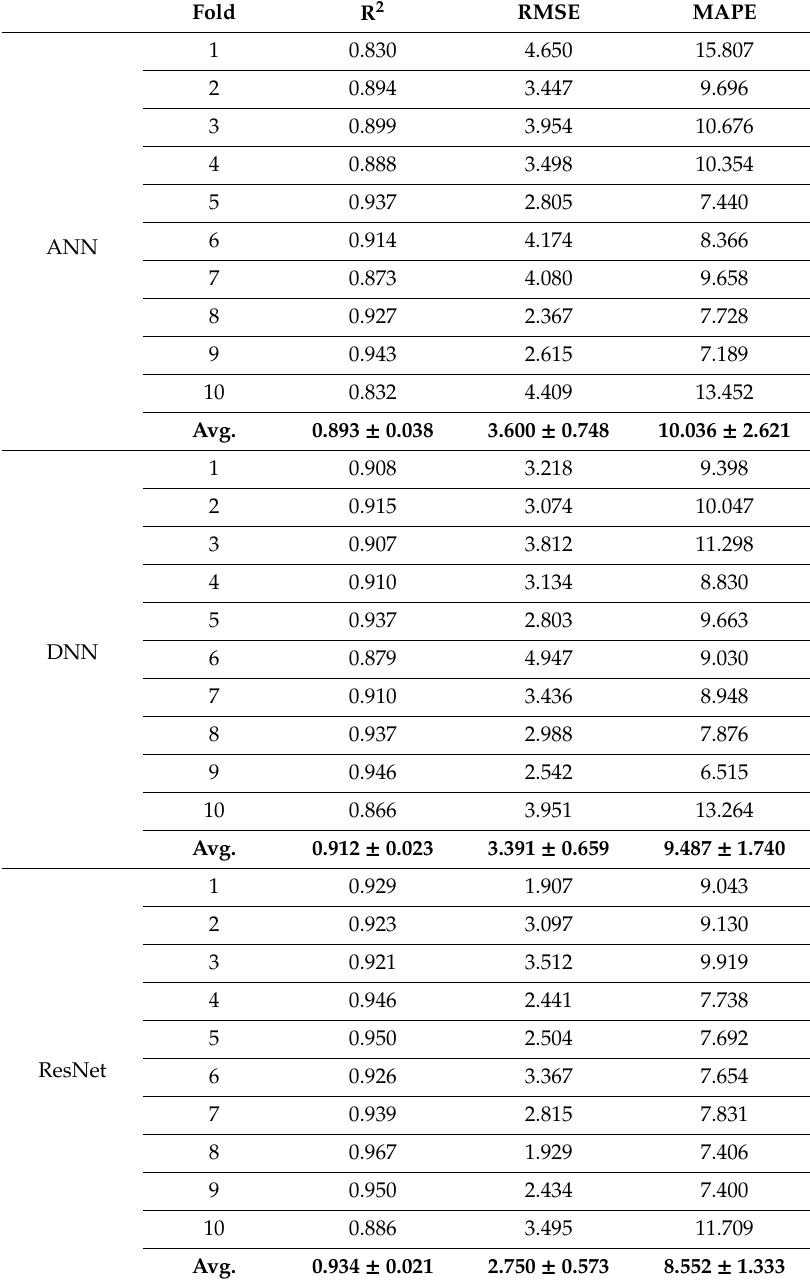
Table 5. Accuracy measurements on validation sets for the proposed machine learning approaches (architectures 1, 3, and 6) under K-fold cross validation scheme.